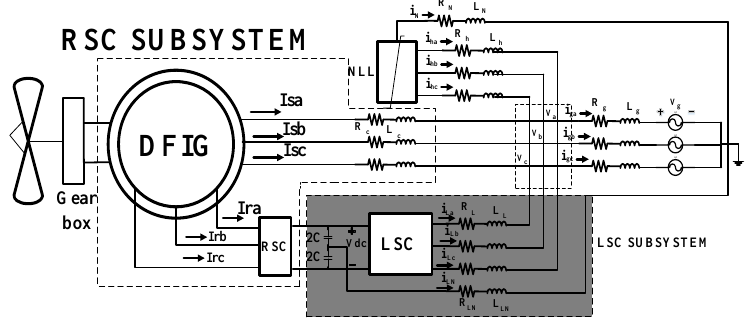
Figure 18. System configuration.